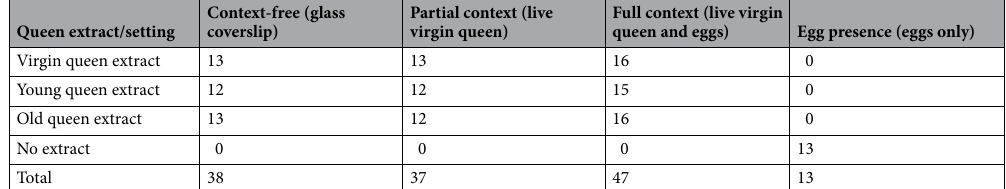
Table 1. The experimental design and sample size used in the study. Worker reproduction was examined in three different contexts with three types of queen extracts. The numbers within the table denote numbers of cages. Each cage contained two newly-emerged workers that were frozen on day